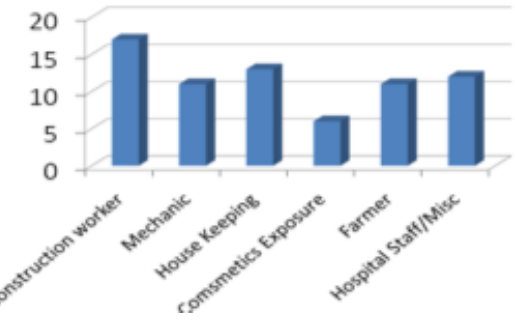
Figure 3: Bar diagram showing occupations of the patients.